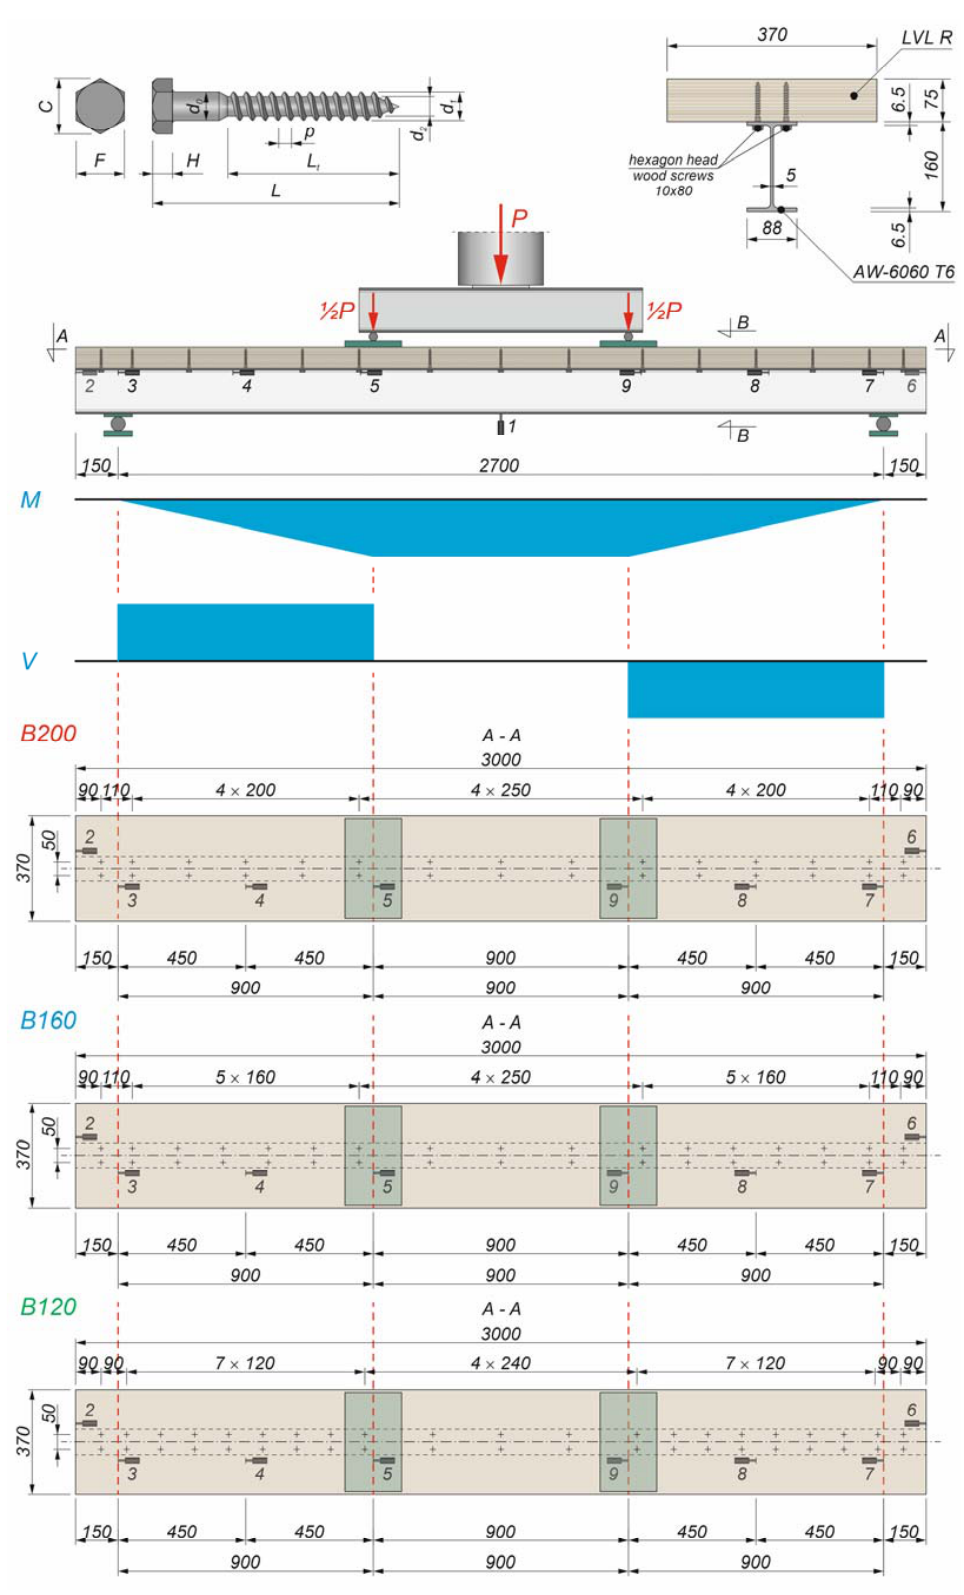
Figure 2. The analysed beams subjected to four-point bending (1–9—linear variable differential transformers).